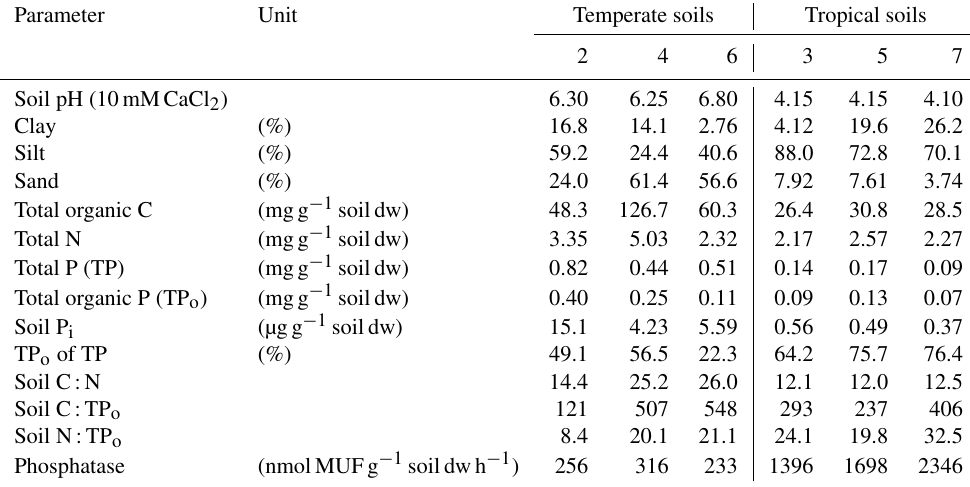
Table 2. Soil characterization of three temperate grassland soils (soil 2, 4 and 6) and three tropical lowland forest soils (soil 3, 5 and 7). Parameter Unit Temperate